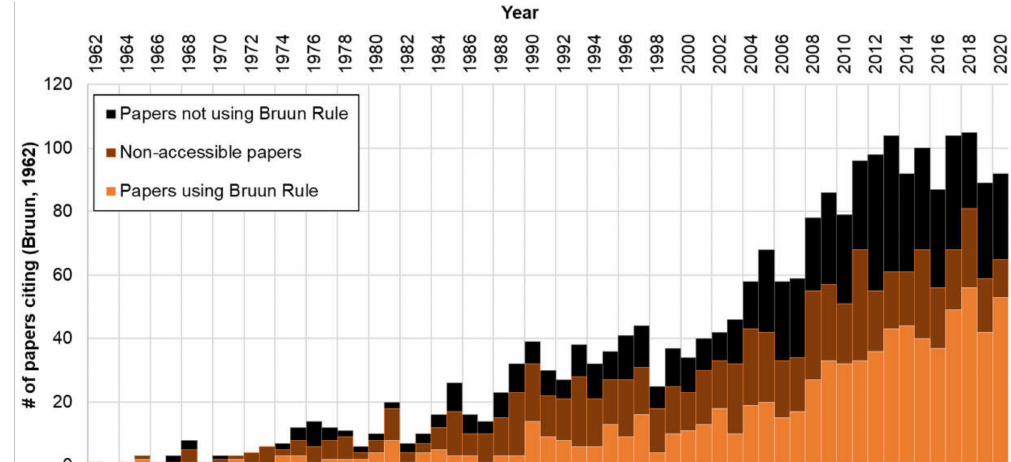
Figure 1. History of papers (per year) that cited Bruun [5] from 1962 to 2020, divided by: papers in which the Bruun Rule is employed (bright orange); non-accessible papers where the use of the Bruun Rule is uncertain (dark shaded orange); and papers citing Bruun [5] but not employing the Bruun Rule (black). Source: Google Scholar ® search